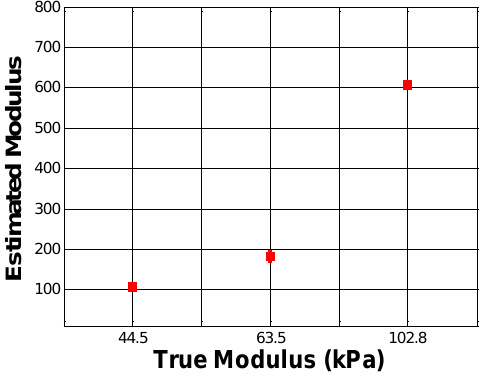
Figure 16. Error bar chart of estimated relative Young’s modulus of each